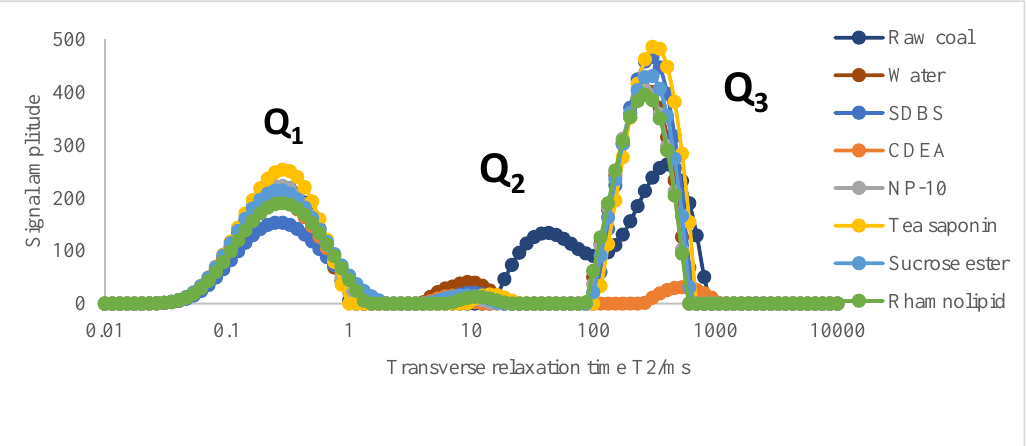
Figure 5. T 2 spectra of coal gas adsorption process modified by different surfactants under 0–2 MPa pressure.